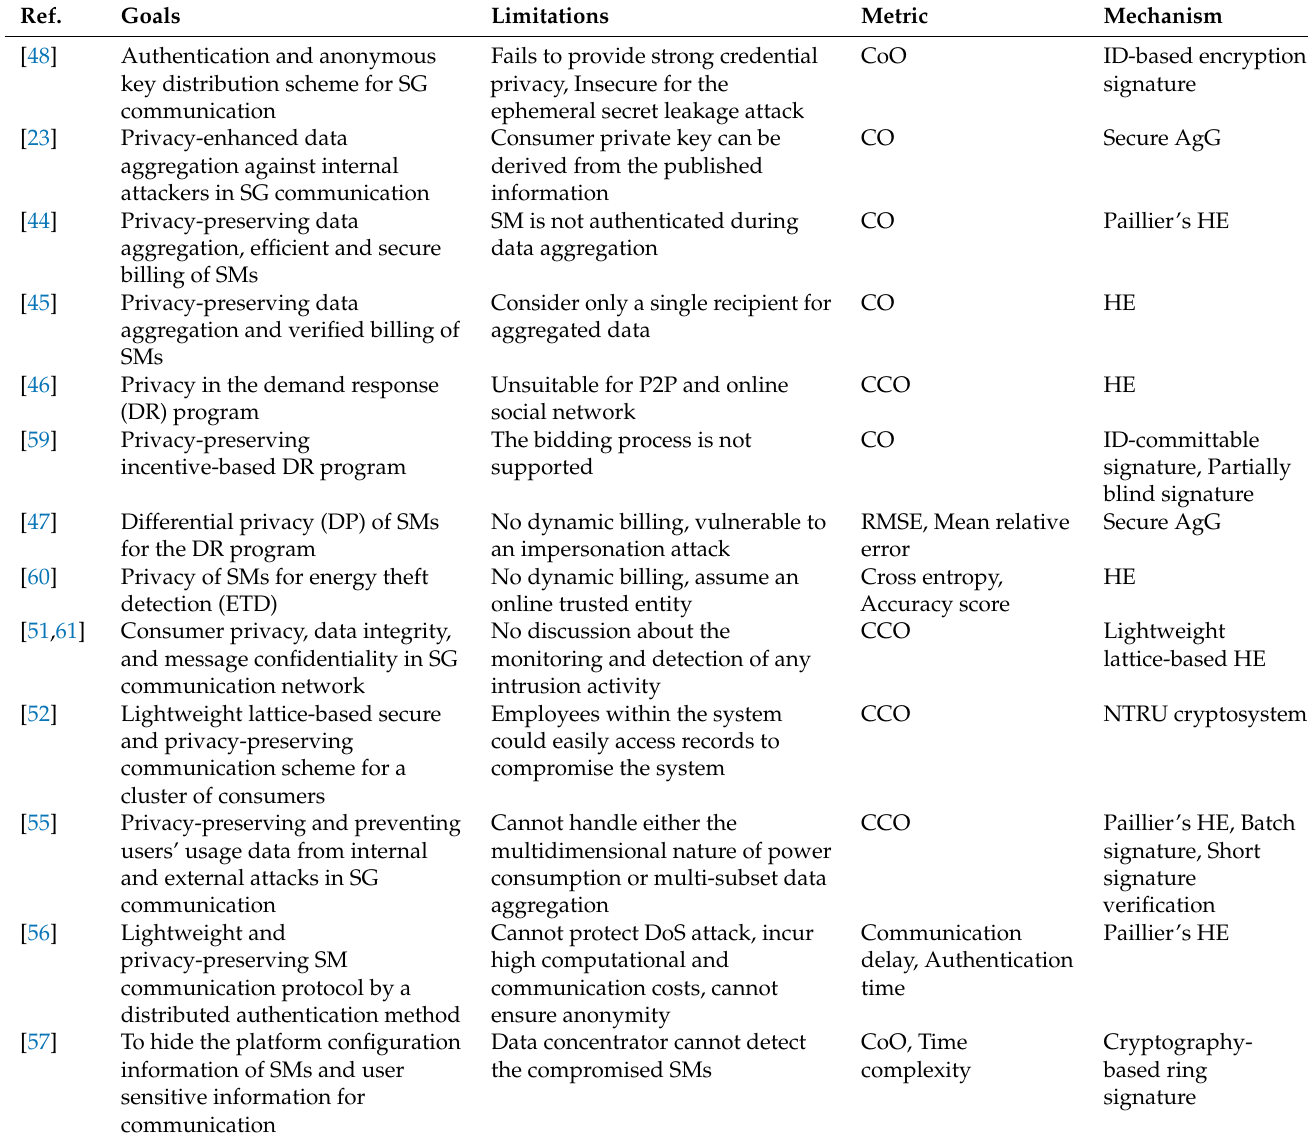
Table 2. Summary of SM privacy-preservation techniques against weak adversaries with